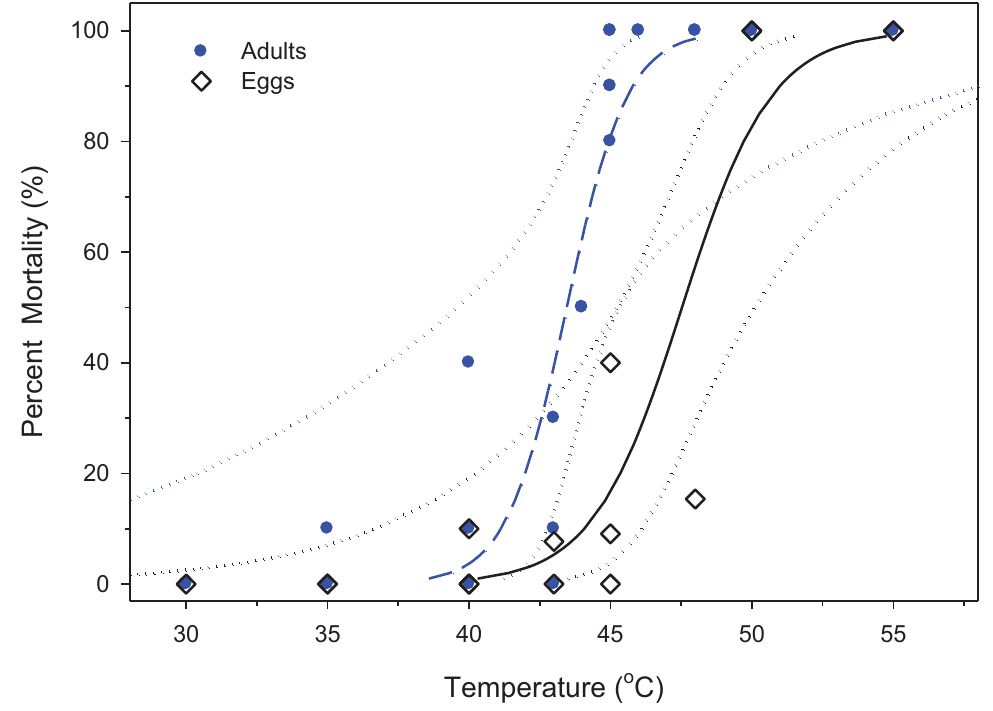
Figure 1. Mortality of bed bug adults ( (cid:2) ) and eggs ( (cid:2) ) when exposed to different final temperatures after a temperature ramp of 0.06 °C/min. Logistic regression for adults (y = 0.943 Log (x) − 40.96; - - -) and eggs (y = 0.636 Log 10 with their respective 95% CLs ( (cid:3)(cid:3)(cid:3)(cid:3) and (cid:3)(cid:3)(cid:3)(cid:3)